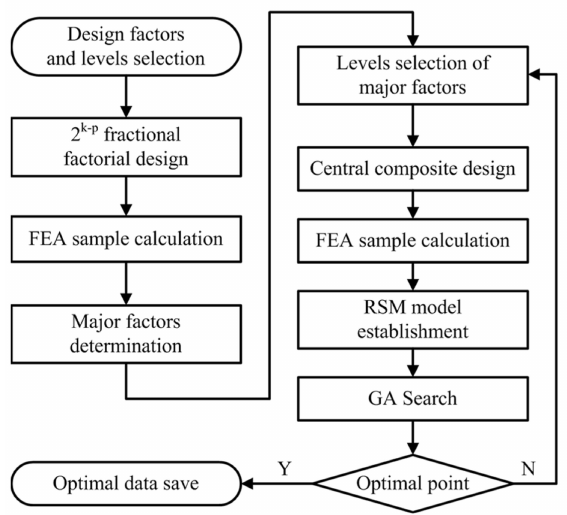
Figure 4. Flow chart of the optimization